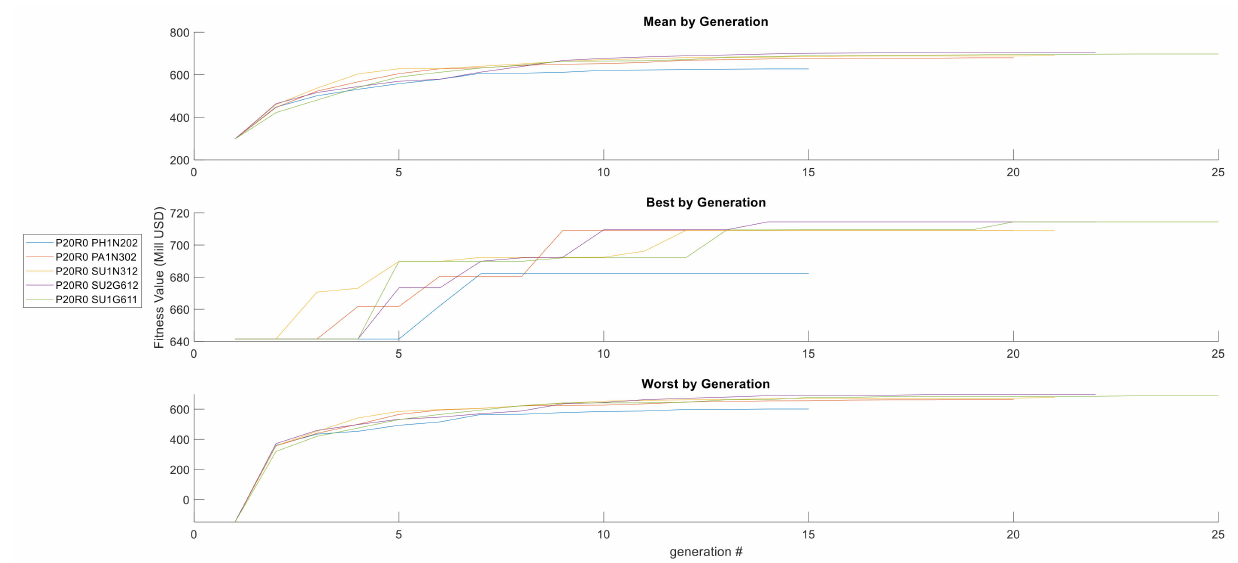
Figure 23. Comparison of the most relevant cases of analysis